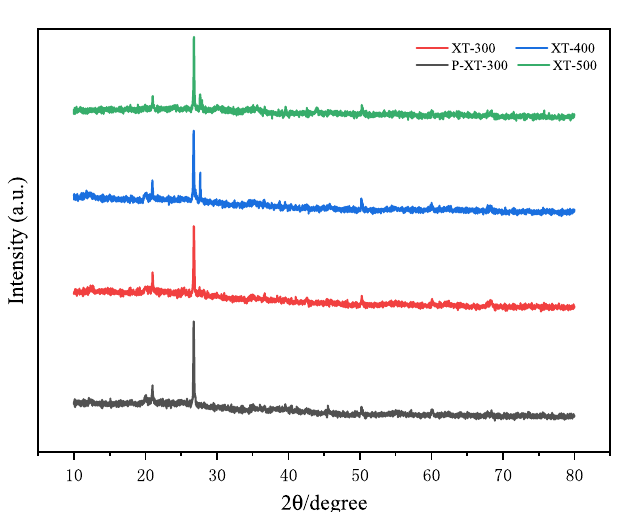
Figure 8. Scanning electron microscope of adsorbents at different temperatures ( a ) XT-300, ( b ) XT-400, ( c ) XT-500.